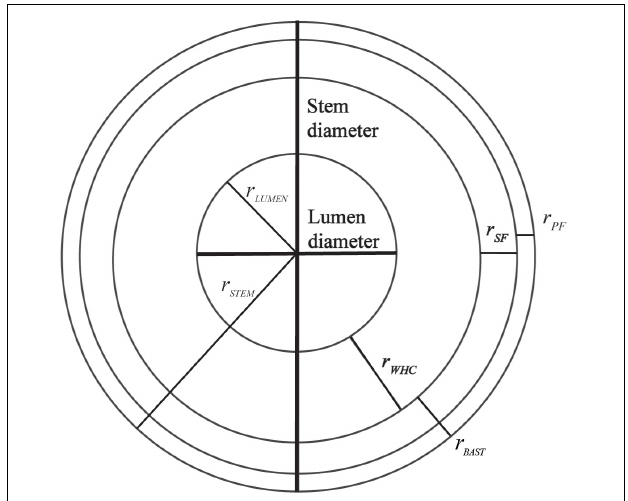
FIGURE 1 | Radius of the different parts of the stem that were used to determine the areas and ratios of different stem structures.